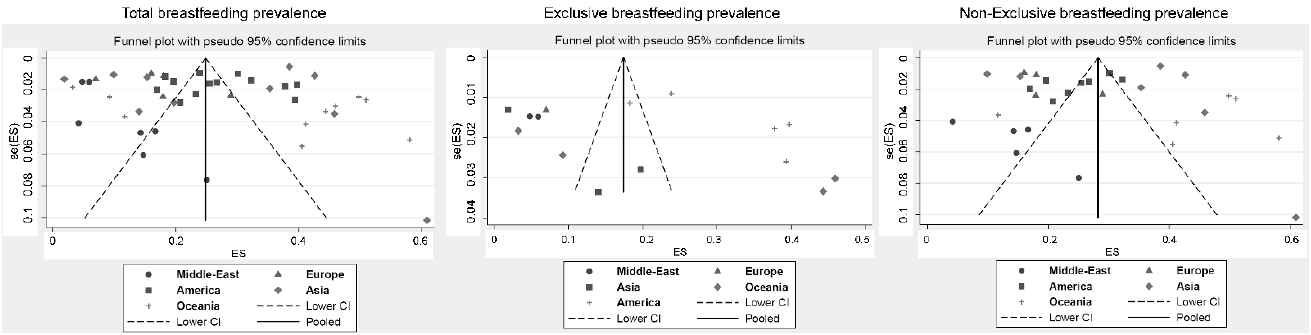
Figure 3. Meta-funnels. Figure 3.